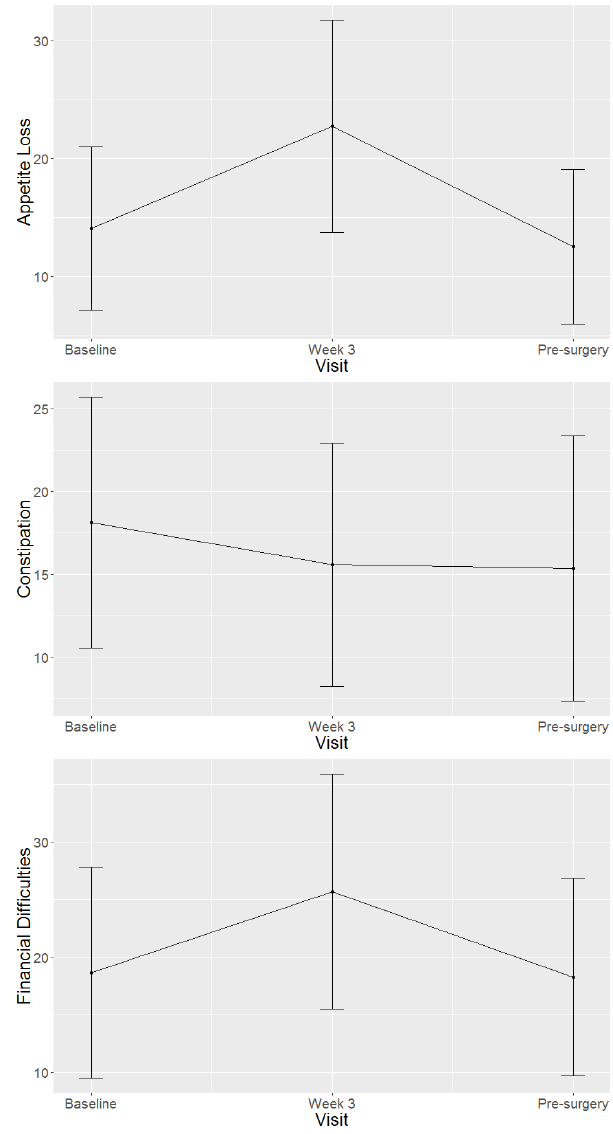
Figure 1. Line graphs illustrating the health-related quality of life scores at baseline, week three of treatment and pre-surgery for each domain. Means and confidence intervals are shown.